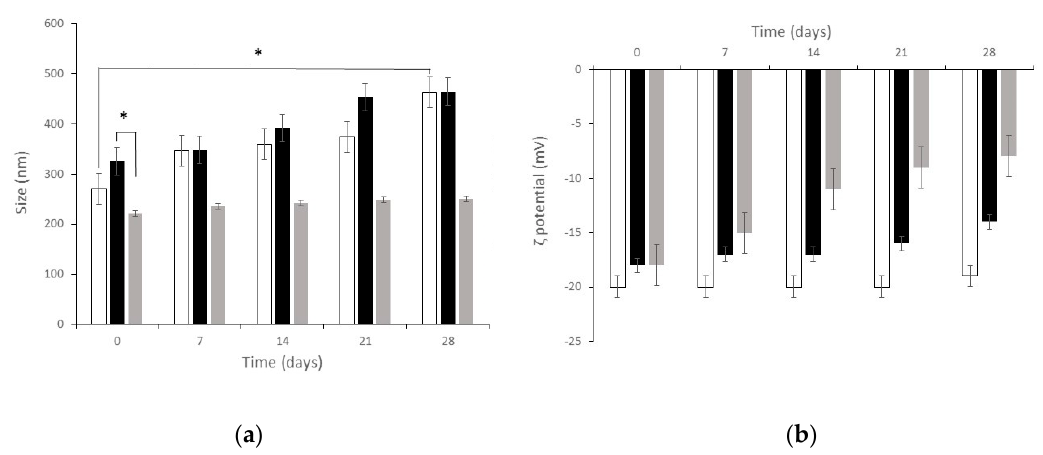
Figure 6. Physico-chemical stability at 4 °C of blank SLN (white) and of dCEF-SLN (grey) and dCEF-S-TNH (black) in term of: ( a ) mean size and ( b ) ζ potential. Each bar represents the mean ± SD ( n = 5); * ( p < 0.05).